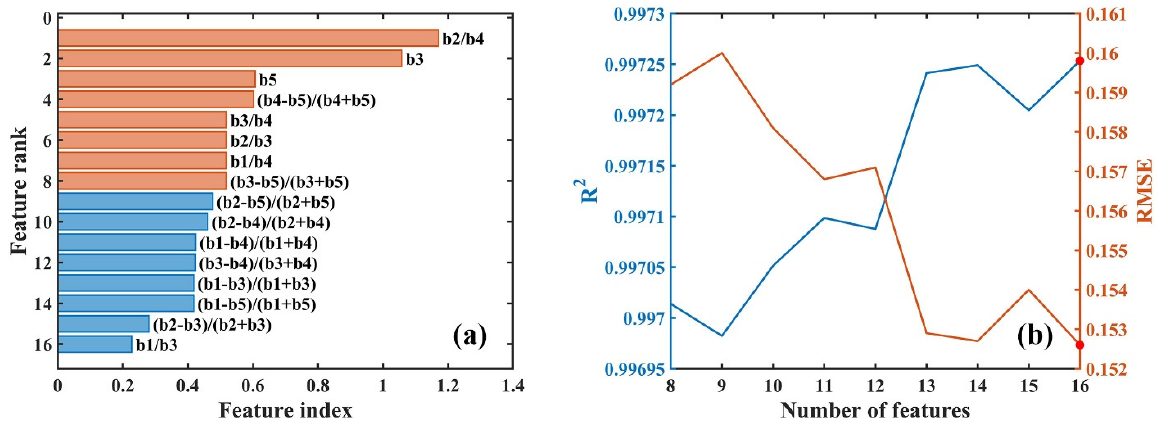
Figure 6. ( a ) The rank of 16 features with a high R-value (R > 0.5) by using the mRMR approach; ( b ) R2 and RMSE of the depth retrieval model under the different numbers of features.